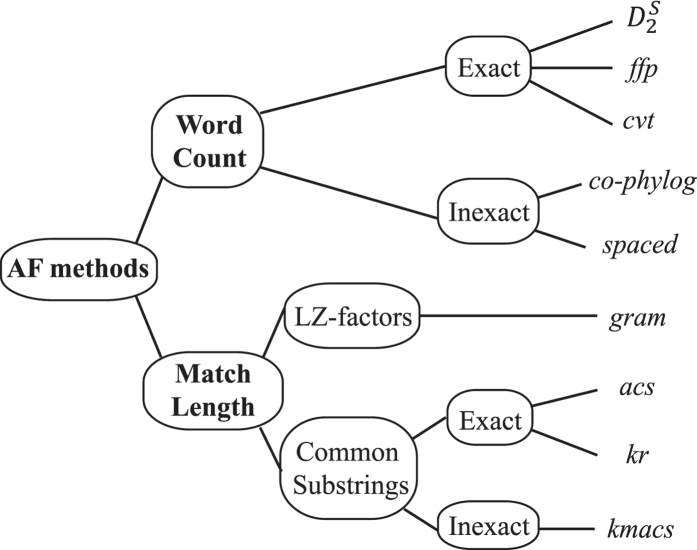
Alignment-free methods classification.Classification of alignment-free methods, modified following Haubold15. LZ: Lempel-Ziv.